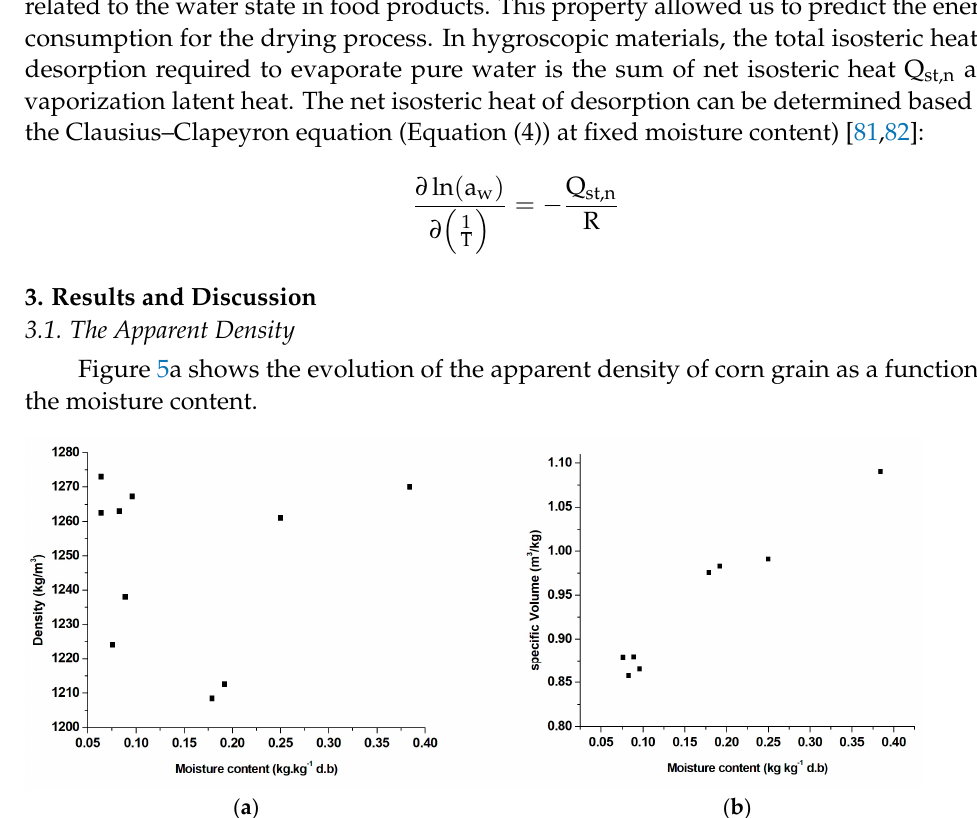
Figure 5. The evolution of the apparent density ( a ) and the specific volume ( b ) of corn grain as a function of the moisture content.